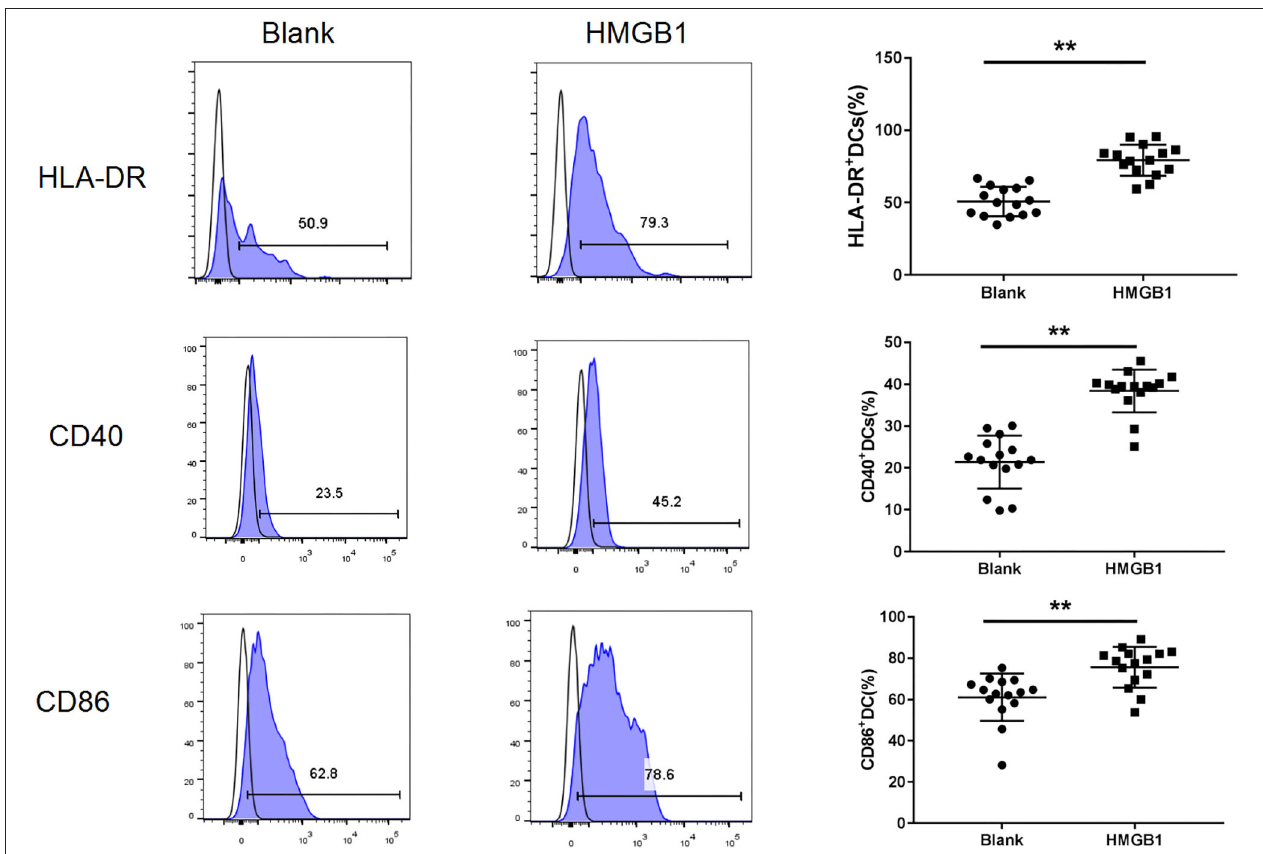
FIGURE 3 | HMGB1 promoted activation of mDCs from SLE patients. Flow cytometry analysis of HLA-DR, CD40, and CD86, surface expression on each group mDCs from SLE patients. The expression of HLA-DR (79.27 ± 10.78% vs. 50.77 ± 10.14%, t = 7.455, P = 0.00), CD40 (38.42 ± 5.10% vs. 21.41 ± 6.33%, t =